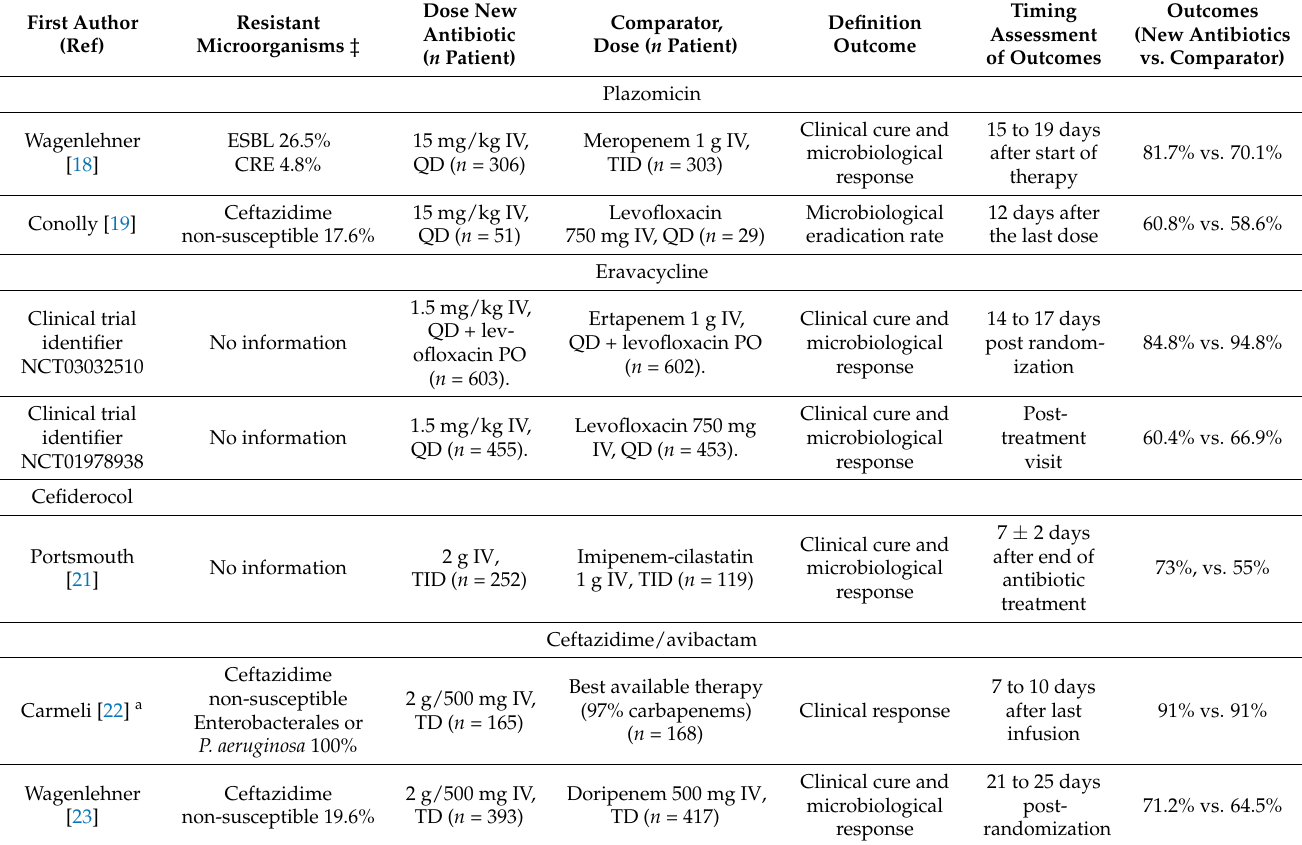
Table 1. Clinical trials in complicated urinary tract infection